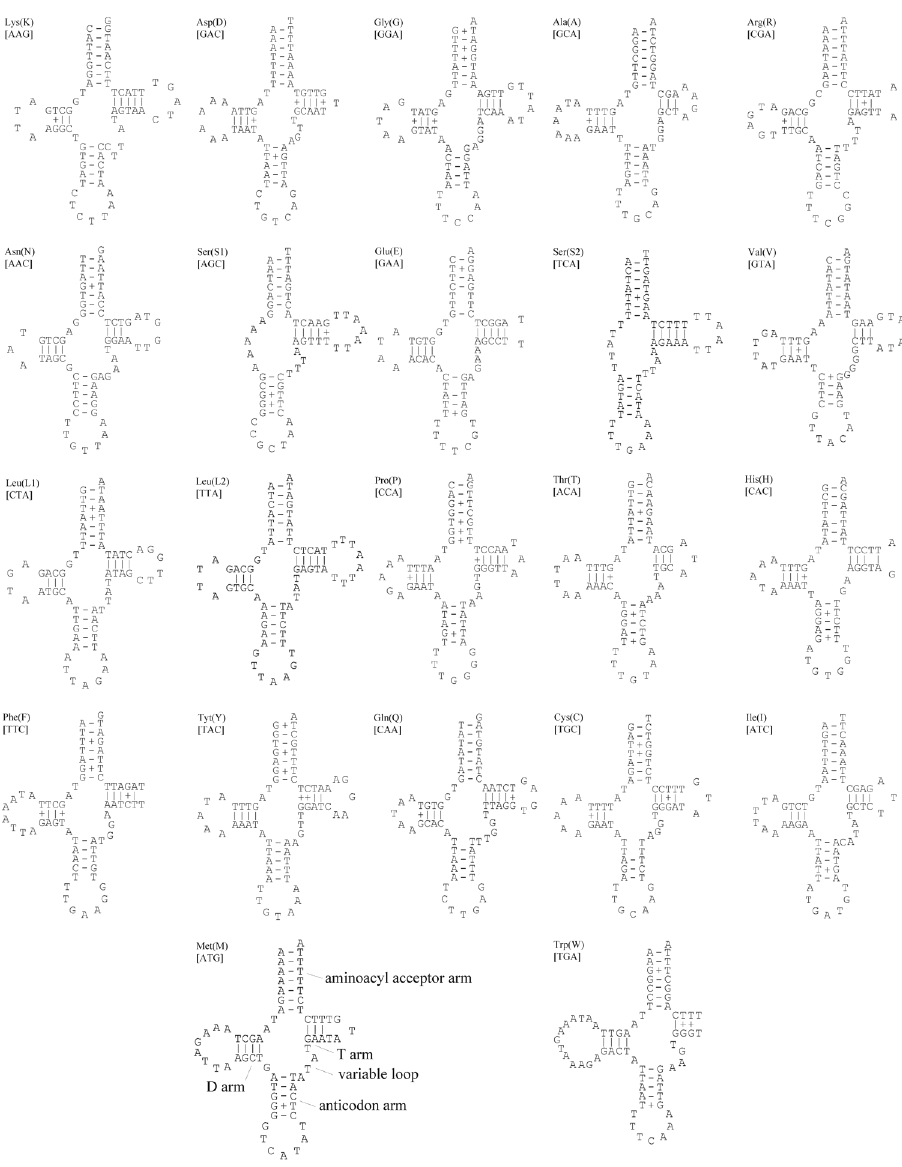
Figure 4. Putative secondary structures of the 22 tRNA genes of Xystodesmus sp . Watson-Crick base- pairing is indicated by solid lines, and G–T pairs are indicated with plus